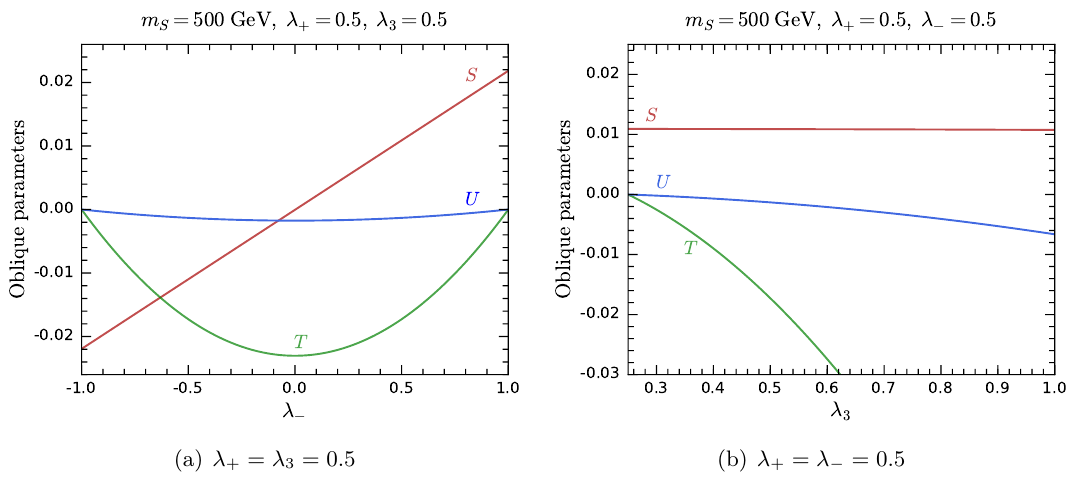
Figure 10 . Electroweak oblique parameters S , T , and U as functions of λ − for λ + = λ 3 = 0 . 5 (a) and of λ 3 for λ + = λ − = 0 . 5 (b). For both panels, m S = 500 GeV